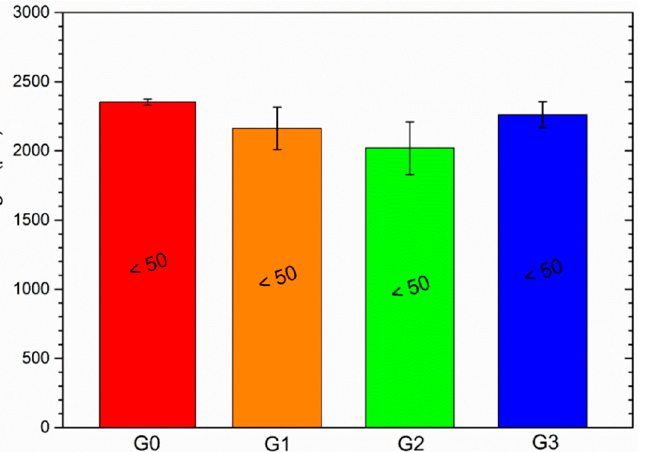
Figure 5. Indentation lengths of the Buchholz test notches, with the corresponding Buchholz hardness values.